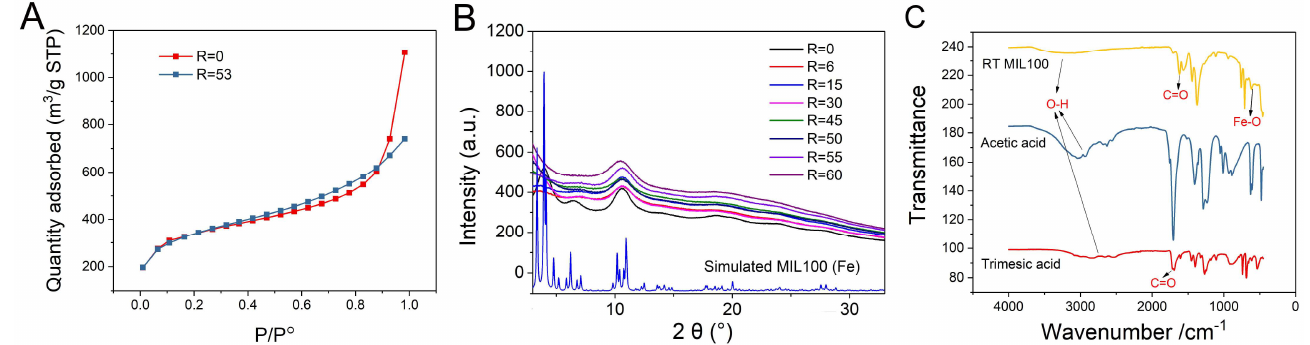
Figure 3. ( A ) Porosimetry characterization of RT MIL100 (R = 0) and RT MIL100 (R = 53) at 77.3 K; ( B ) PXRD patterns of RT MIL100 synthesized at different ratios of the modulator and trimesic acid (R = 0–60); ( C ) ATR IR spectrums of RT MIL100 (R = 53), acetic acid, and trimesic acid.